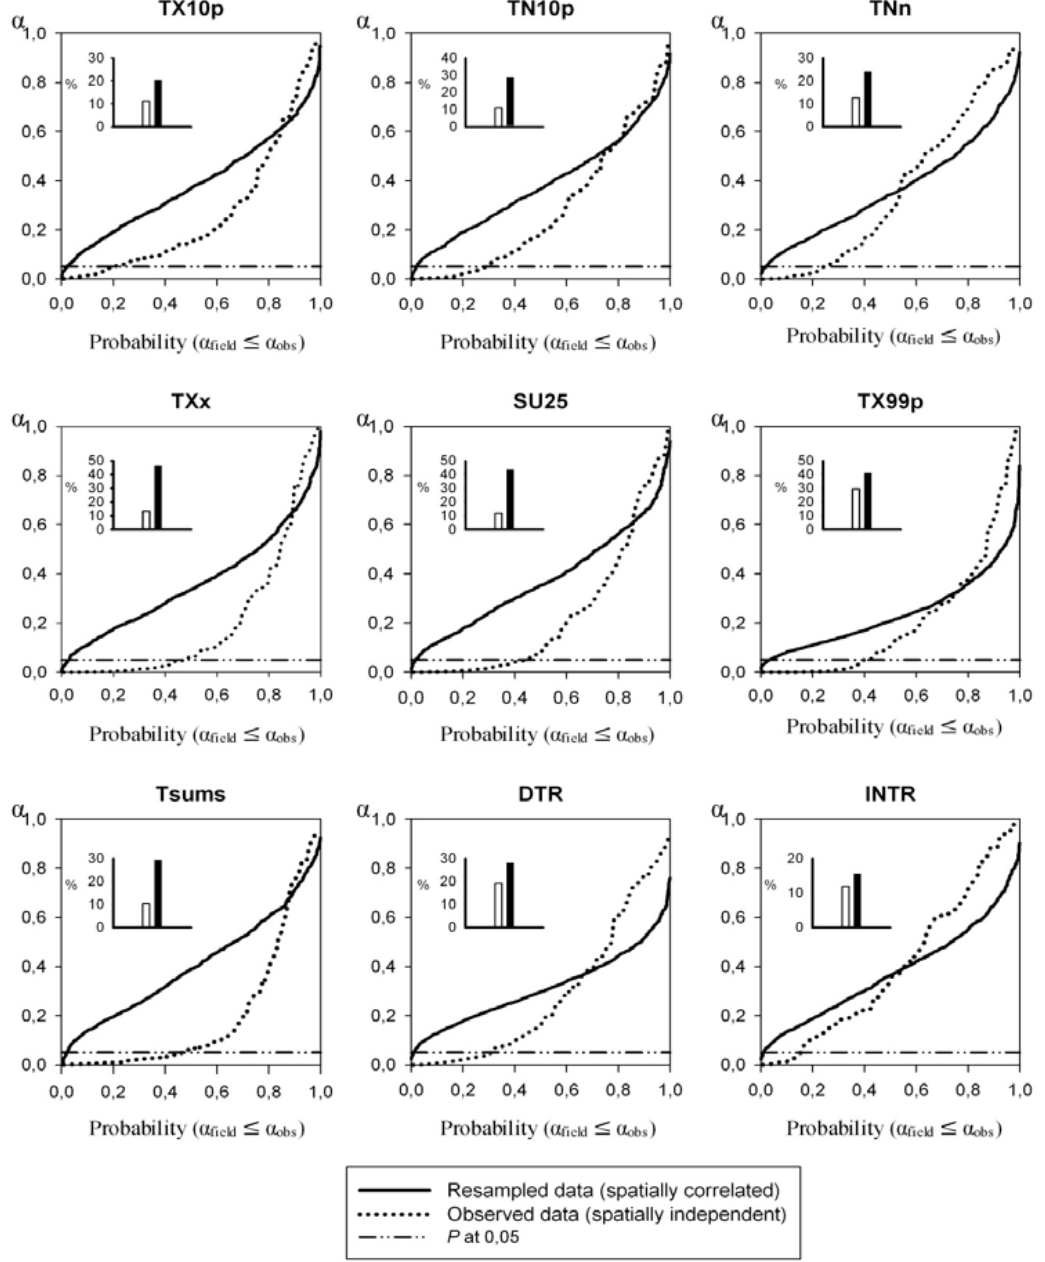
Figure 4. The empirical cumulative distribution function (cdf) of the significance levels of the trends for the resampled and observed data for a selected number of indices. Bar lines in the upper panel show percentage of the observed series ( ■ ) and the resampled series ( □ ) with statistically significant trend at p < 0.05.